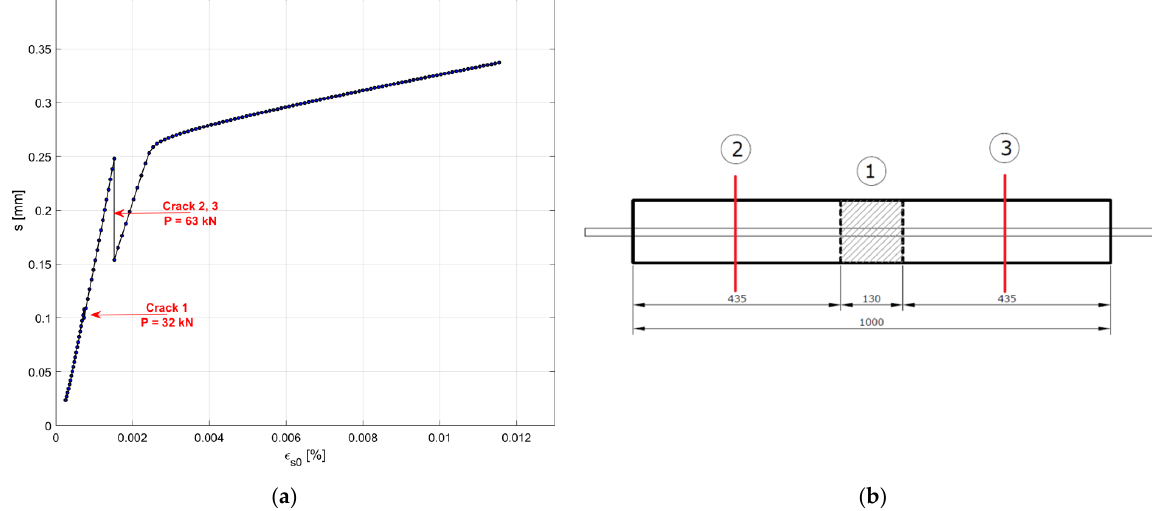
Figure 14. Analytical slip–strain diagram for specimen n.1 ( a ), and the location of the three cracks numbered according to the sequence of occurrence (unit: mm) ( b ).